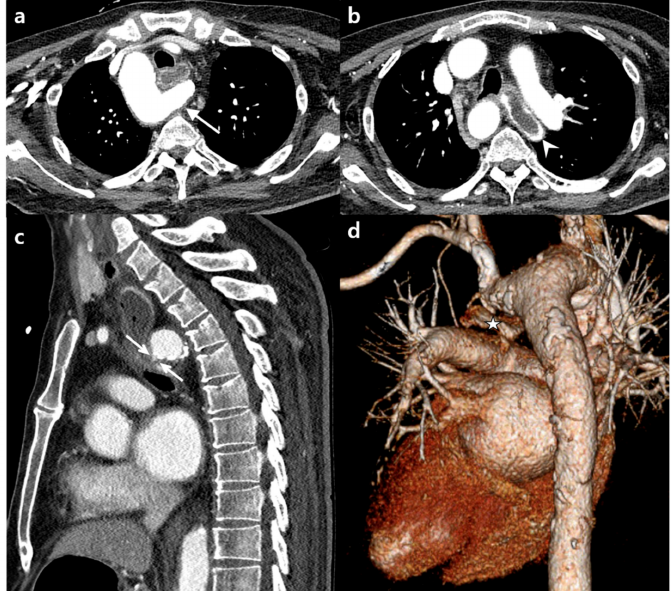
Figure 4. ( a ) Axial chest CT scans taken at the second visit showing the right aortic arch and retroesophageal aberrant left subclavian artery (ALSA, diverticular portion, arrow). ( b ) Note the contrast filling in the elongated esophagus (arrowhead). ( c ) Sagittal reformation image showing focal contrast extravasation from the diverticular portion of the ALSA into the esophagus (double arrows), possibly indicating an arterial-esophageal fistula. ( d ) Three-dimensional volume rendering image showing the relationship between the esophagus and the aberrant left subclavian artery. The esophagus (star) is compressed posteriorly and inferiorly by the diverticular portion of the